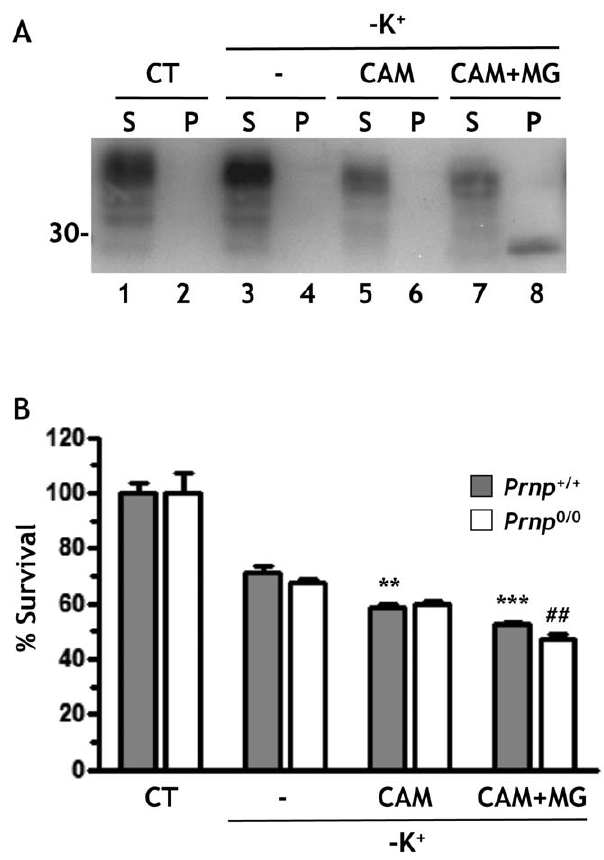
Figure 7. SP-PrP does not affect the cerebellar granule neurons’ response to serum and potassium deprivation. (A) Cerebellar granule neurons from C57BL/6J mice were shifted to serum- free medium containing 5 mM KCl, and left untreated (-) or treated with 10 m M CAM741 alone or in combination with 10 m M MG132 to induce accumulation of SP-PrP. After 24 h cells were analyzed by Western blot with antibody 12B2 to verify the induction of SP-PrP. (B), Cell survival was quantified by MTT assay and expressed as a percentage of the values for untreated cells. Data are the mean 6 SEM of 12 replicates; ** p , 0.01, *** p , 0.001 vs -K + in Prnp + / + ; ## p , 0.01 vs -K + in Prnp 0/0 by Bonferroni test.